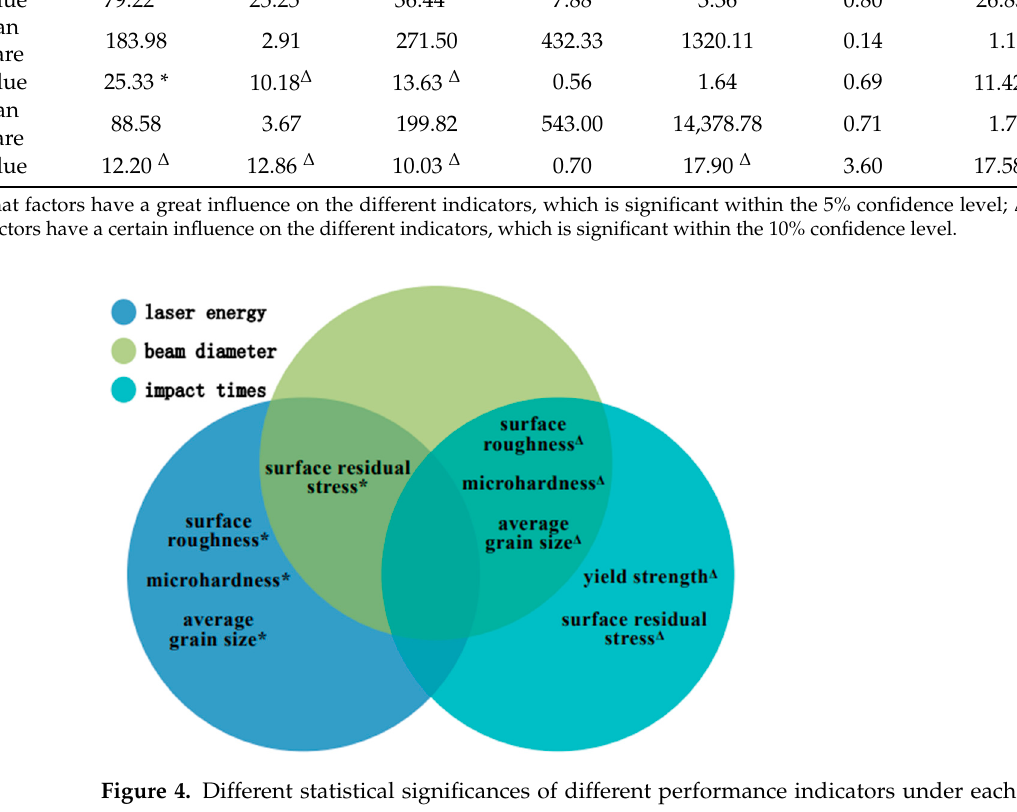
Figure 4. Different statistical significances of different performance indicators under each factor condition.